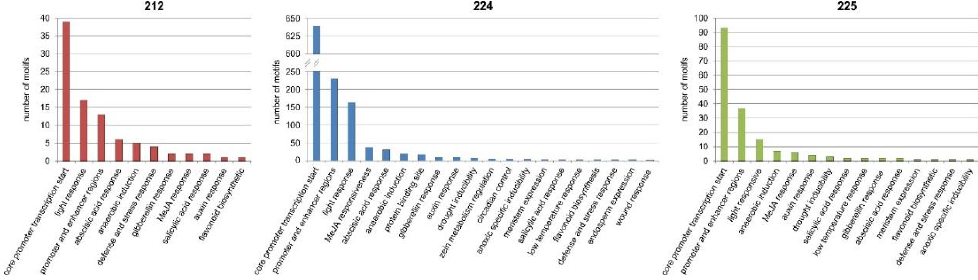
Figure 6. Promoters analysis - occurrence of the different types of motifs in upstream promoter regions of the differentially expressed genes.